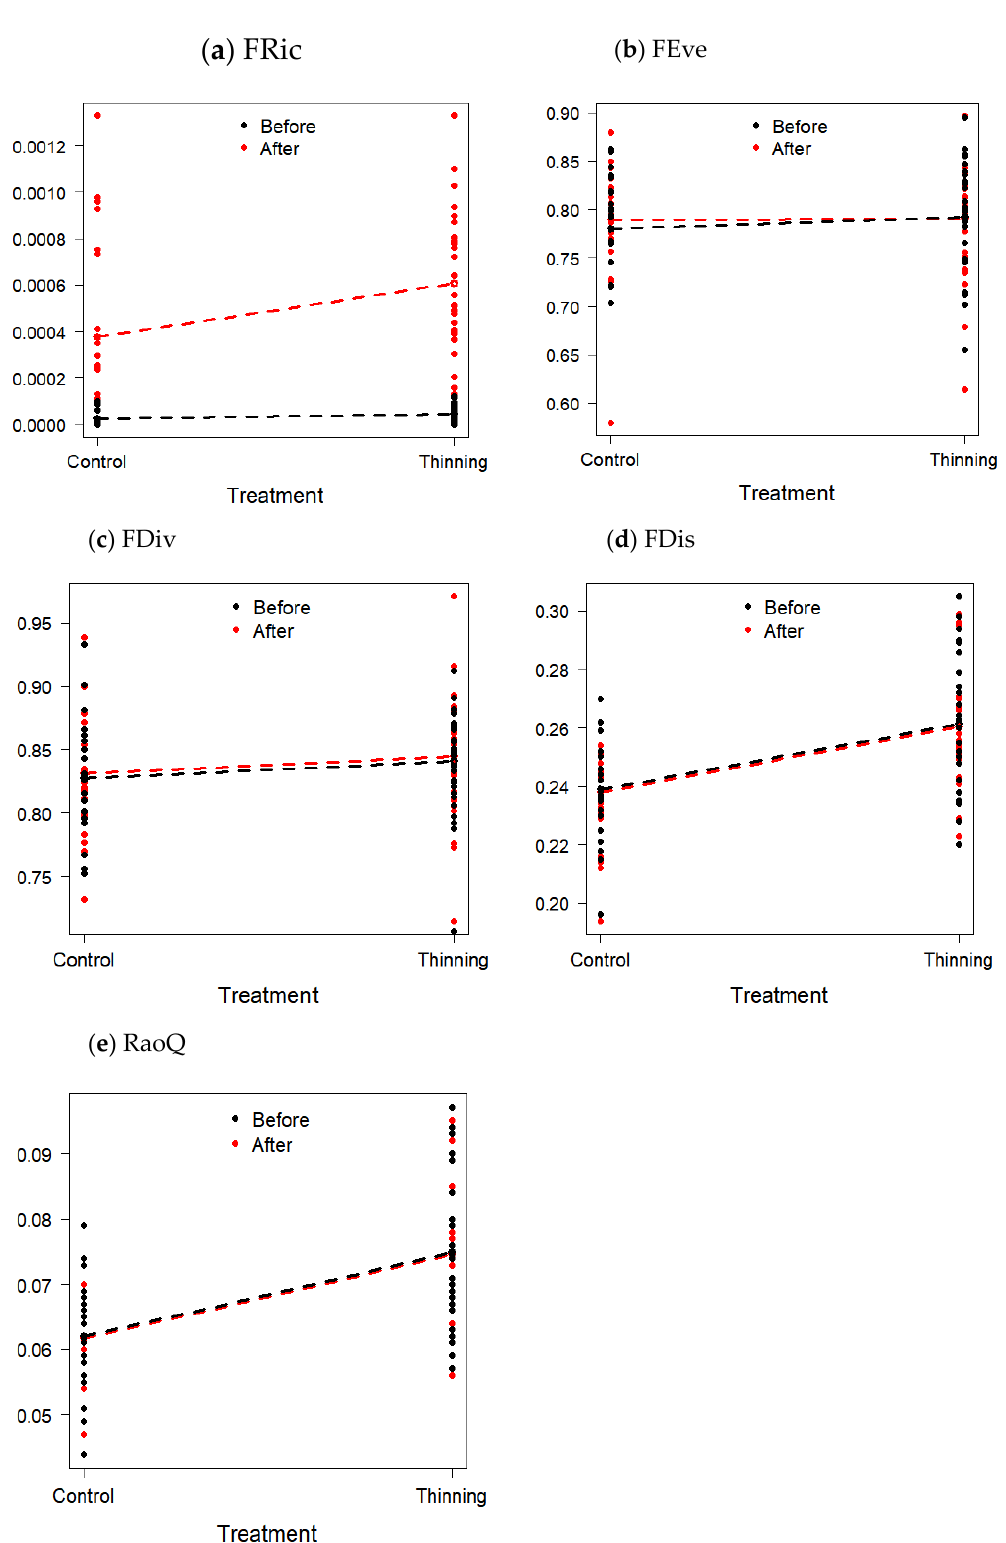
Figure 2. Effects of thinning on functional diversity indices ( n = 52) before and after implementation of selective thinning. ( a ) Functional Richness (FRic), ( b ) Functional evenness (FEve), ( c ) Functional divergence (FDiv), ( d ) Functional dispersion (FDis) and ( e ) Rao Quadratic entropy (RaoQ). Details of analyses of variance among control and thinned plots are given in Table 3.